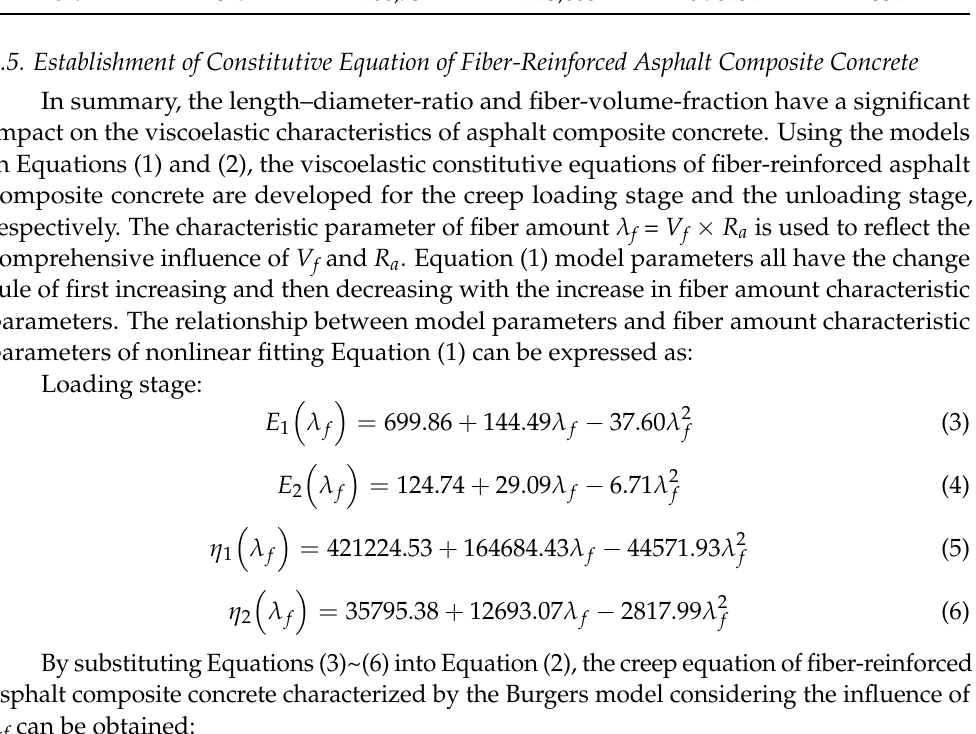
Table 5. Equation (2) model parameters of asphalt composite concrete with different R a . Parameters of Equation (2) Model R a